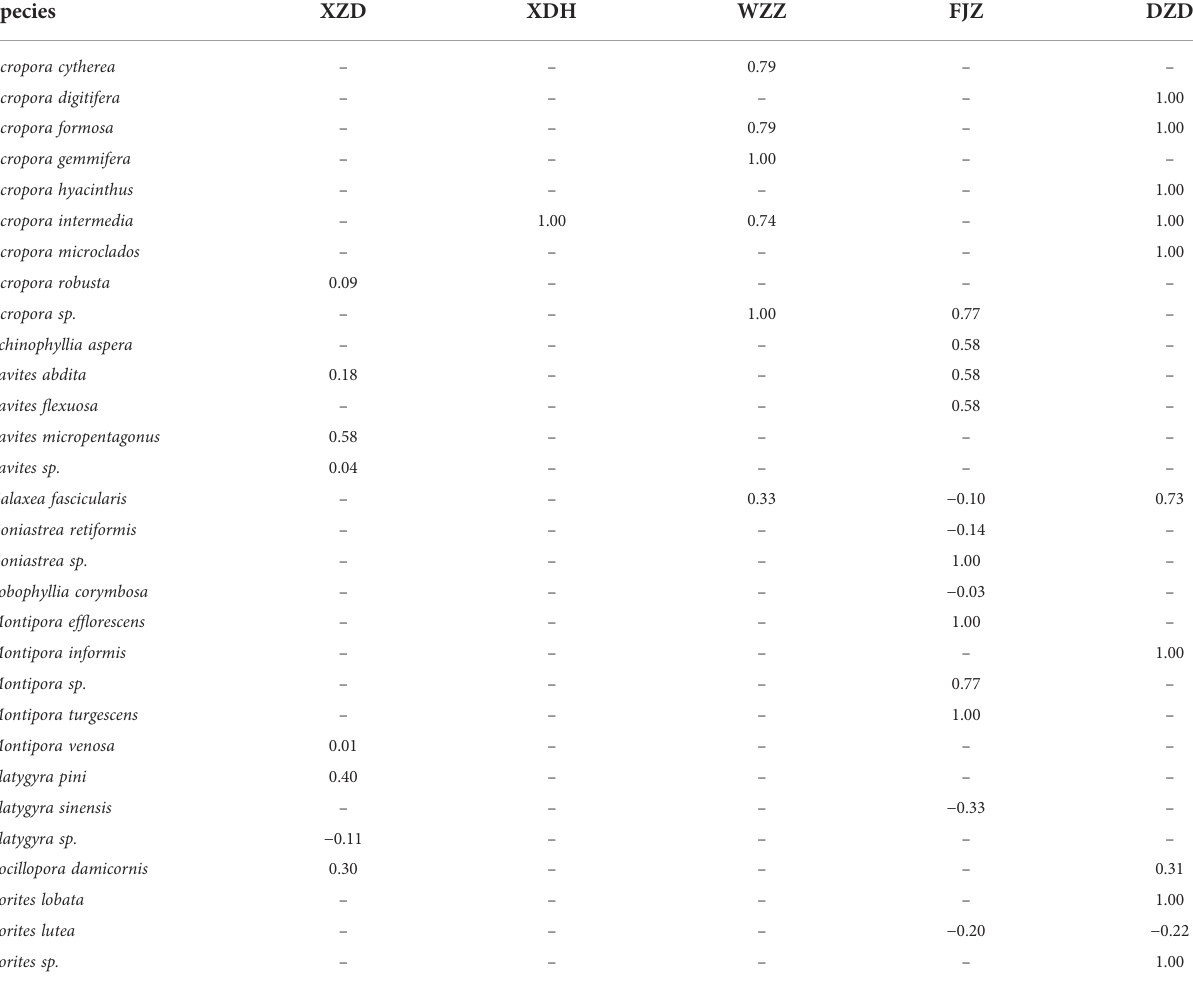
TABLE 1 Feeding preferences of Drupella spp. according to the Ivlev ’ s electivity index (E i ) considering the coral species preyed upon at each station.